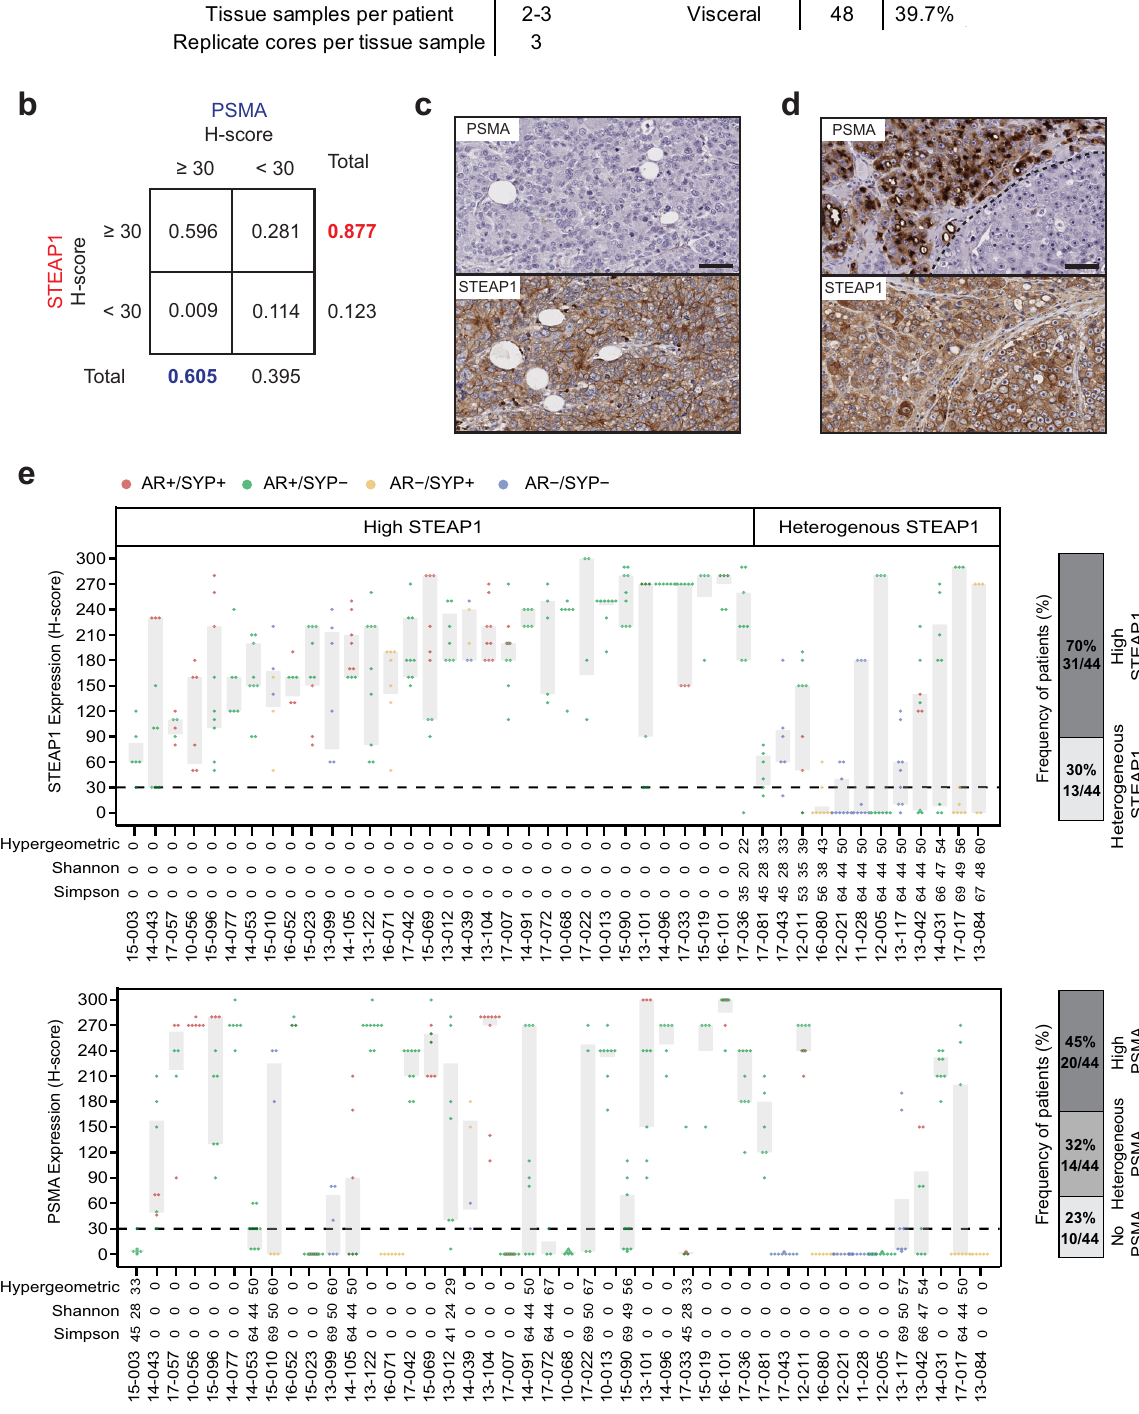
two patterns of STEAP1 expression (Fig. 1e) with 68% (30/44) of patients showing STEAP1 expression across all metastatic sites (high STEAP1) and 32% (14/44) patients showing metastatic sites with and without STEAP1 expression (heterogenous STEAP1). No patients were identi fi ed in which all metastatic tissues lacked STEAP1 expression. A similar analysis for PSMA expression in the same cohort revealed 45%